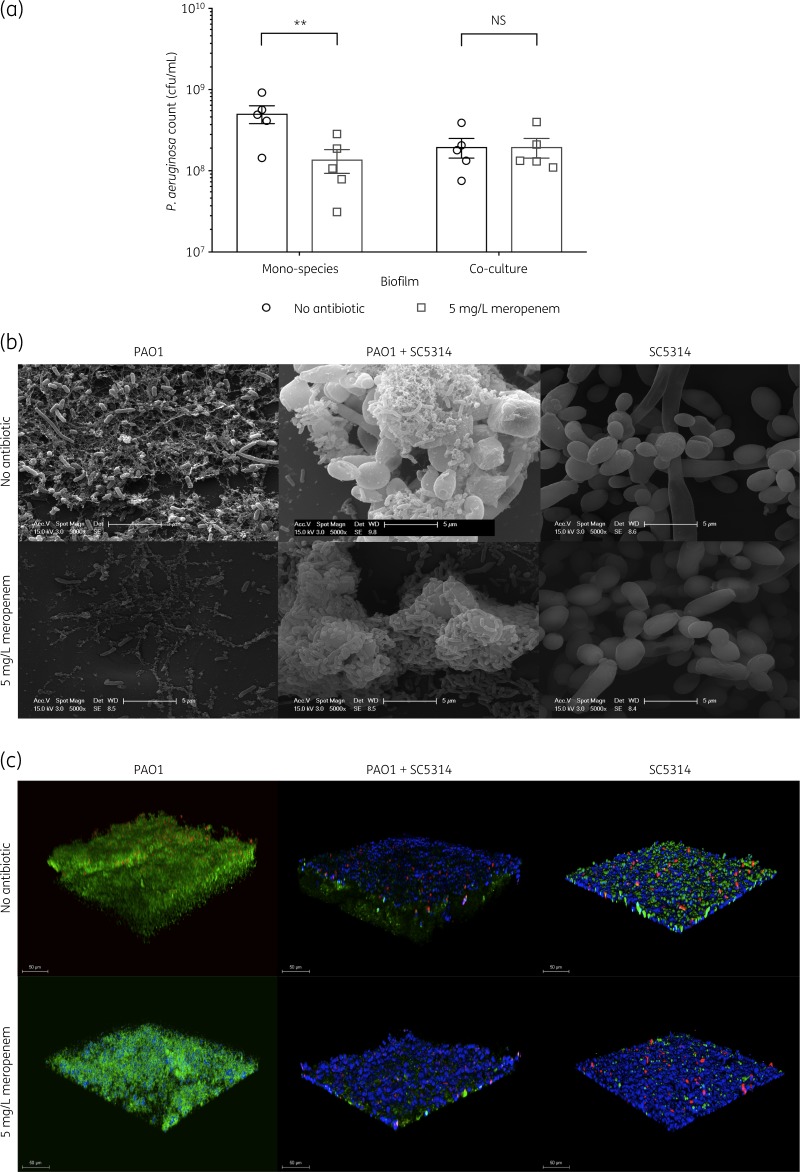

C. albicans increases the tolerance of P. aeruginosa to meropenem in a dual-species biofilm. (a) Preformed 24 h biofilms were incubated for 18 h in MHB containing no antibiotic or 5 mg/L meropenem. Data are the mean ± SEM from five biological replicates. Data were analysed using two-way ANOVA and Holm–Sidak’s multiple comparisons test (**P < 0.01). NS, not significant. (b) Scanning electron microscopy analysis of biofilms. Meropenem treatment of mono-species P. aeruginosa biofilms results in death of bacterial cells, whilst the presence of C. albicans in the dual-species biofilm enhances meropenem tolerance; the tight association of P. aeruginosa cells to fungal surfaces is visible. C. albicans alone is unaffected by meropenem. (c) 3D reconstructions of biofilms from confocal z-stacks. Red indicates propidium iodide stain (dead cells), green indicates Syto 9 dye (DNA) and blue indicates calcofluor white stain (chitin).